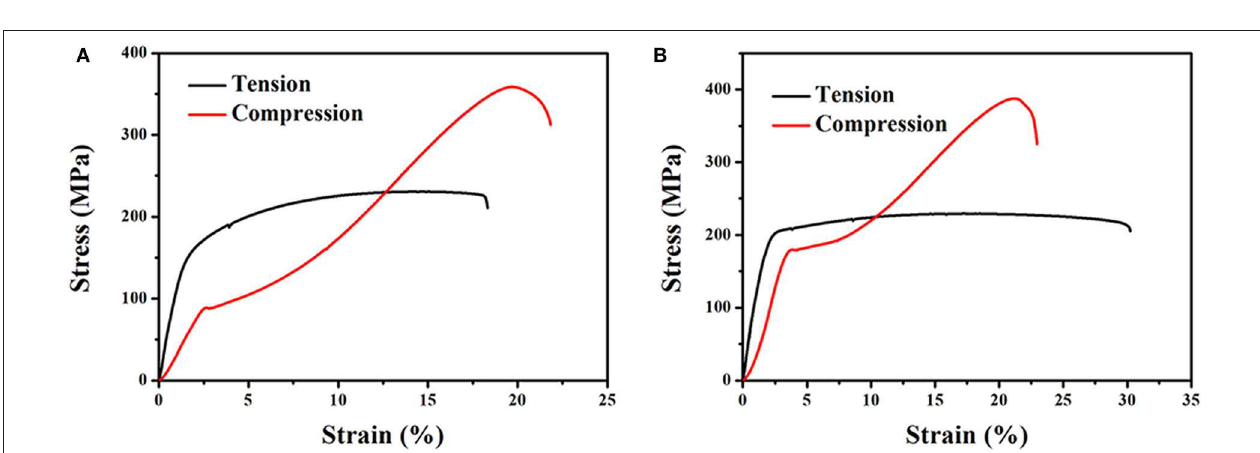
2018; Song et al., 2019). In the present work, Mg − 1Sn −